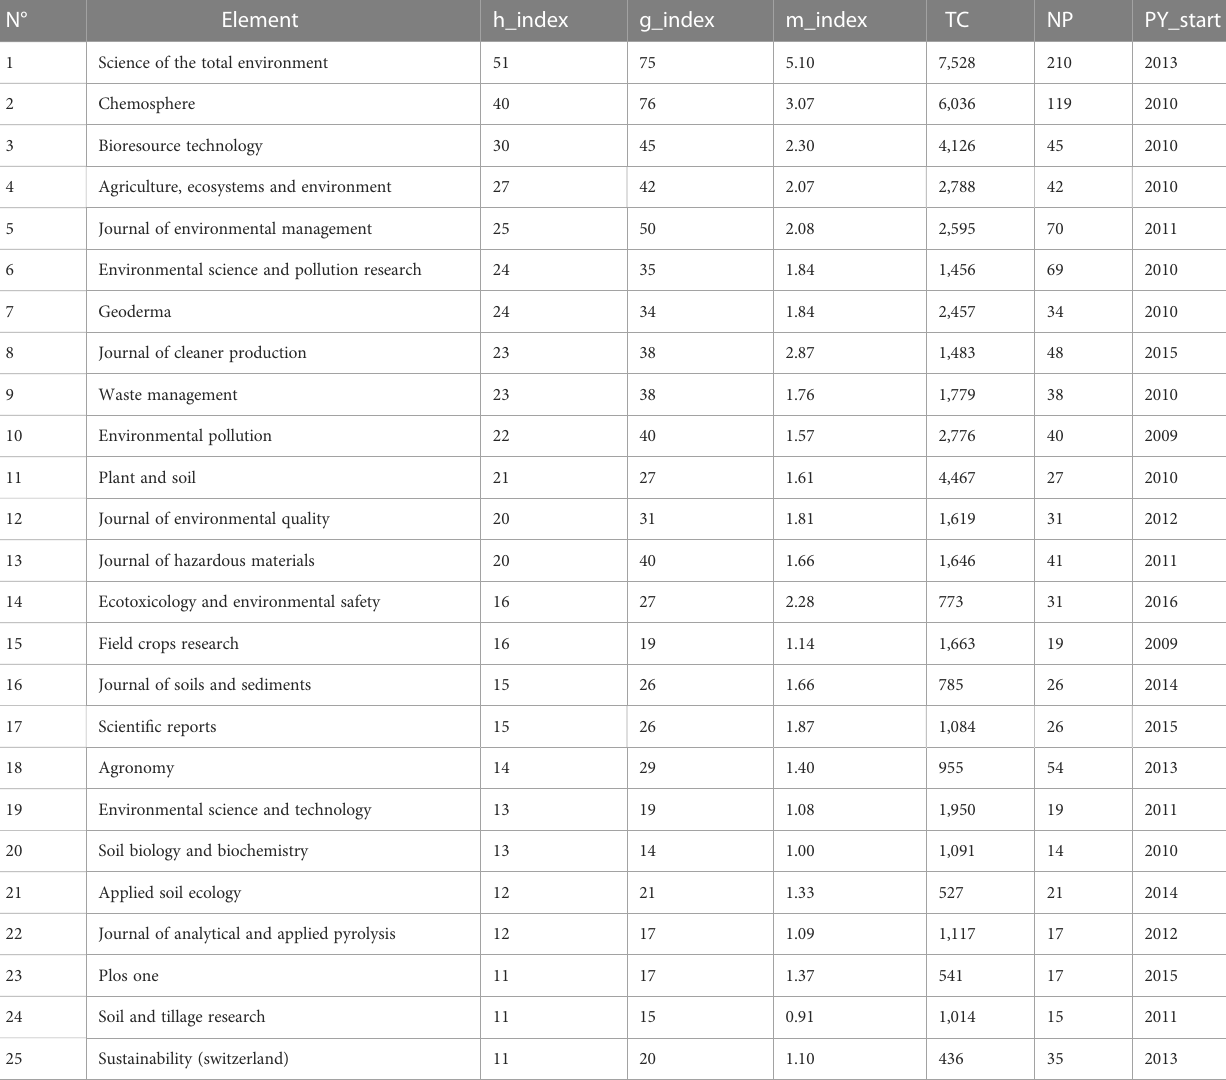
TABLE 2 Impact of the twenty- fi ve most in fl uential publication sources from 2007 to 2022.